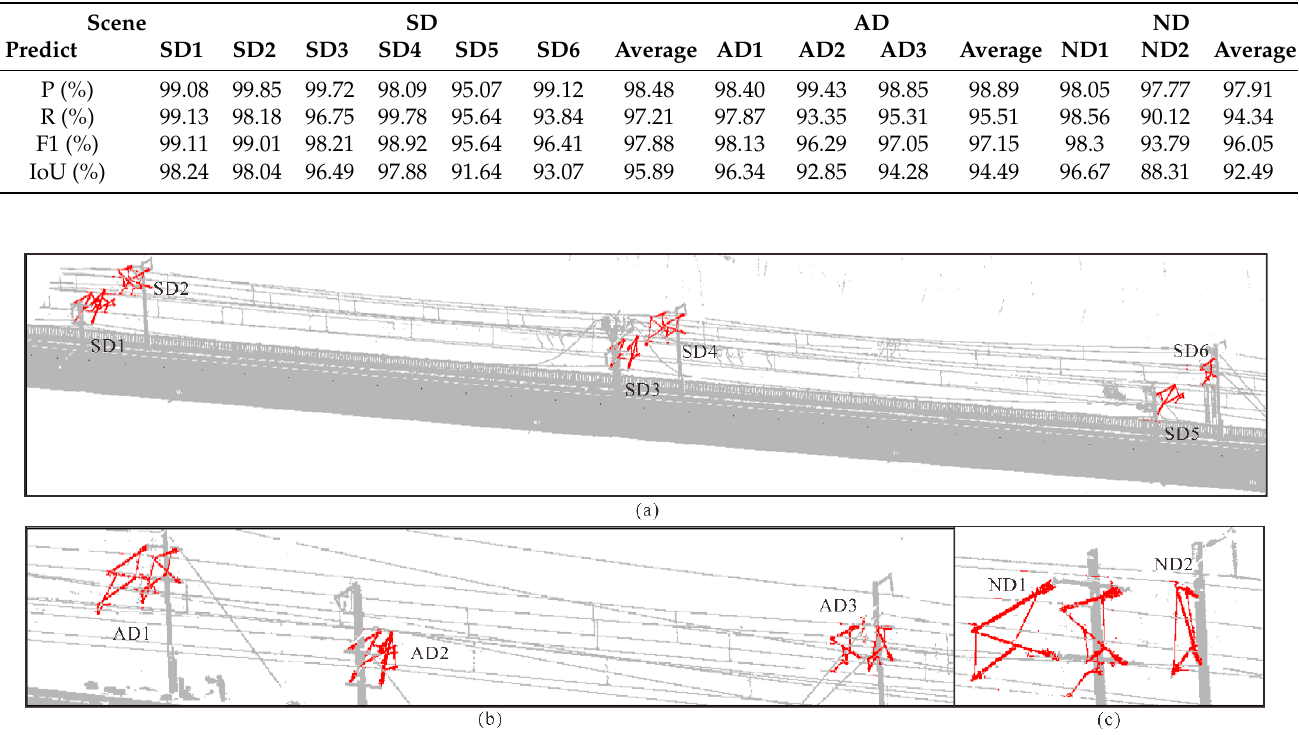
Figure 12. The test results of the support device scenes: ( a ) the SD extraction results, ( b ) the AD extraction results, and ( c ) the ND extraction results.